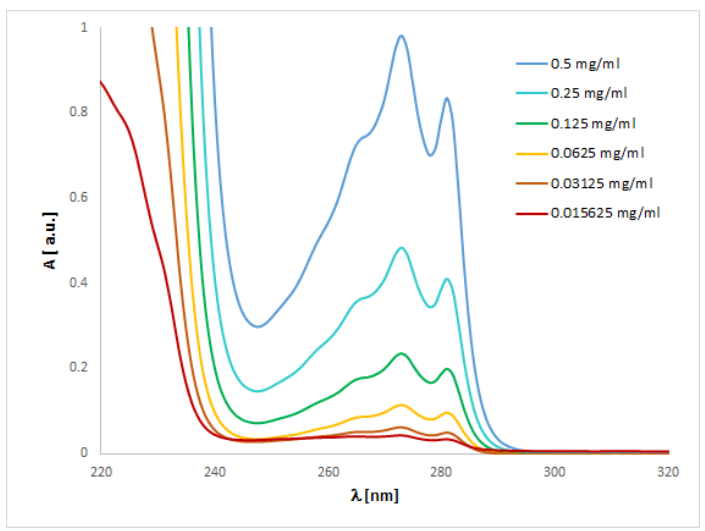
Figure 4. Experimental UV-vis spectrum of isoconazole 1 registered in methanol at various concentrations.